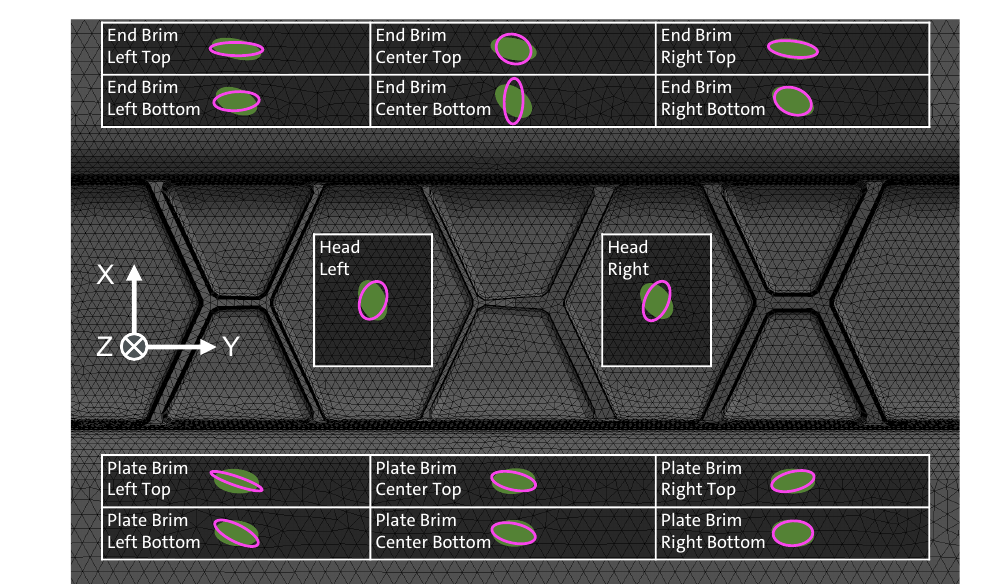
Figure 27. CAD image of the ribbed structure’s middle section (bottom view) with the brims and head analysis areas (white boxes) showing the determined averaged fiber orientations of all three CT scans in green superimposed with the fiber orientations predicted with 3D TIMON CompositePRESS in pink (both displayed as 2D ellipses on the tetra mesh).